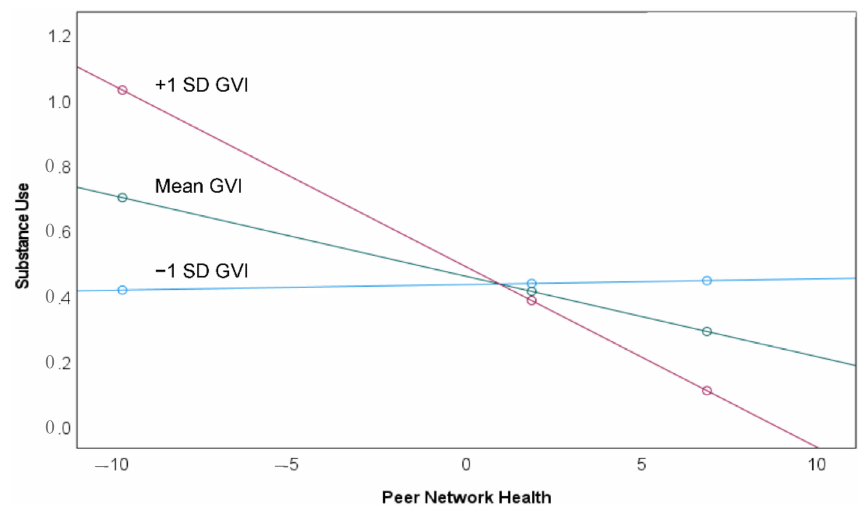
Figure 3. The moderating effect of GVI on the association of peer network health with substance use, where the association differs at locations where GVI is one standard deviation below the mean (blue), at the mean (green), and one standard deviation above the mean (red). The effect of peer network health on substance use is significant for adolescents where residential GVI is at or above the mean, but not where residential GVI is low.